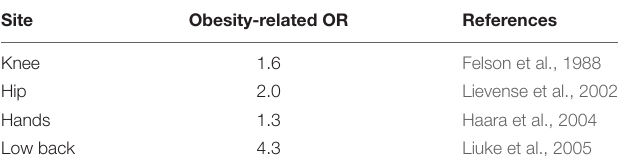
TABLE 2 | Obesity-mediated osteoarthritis (odds